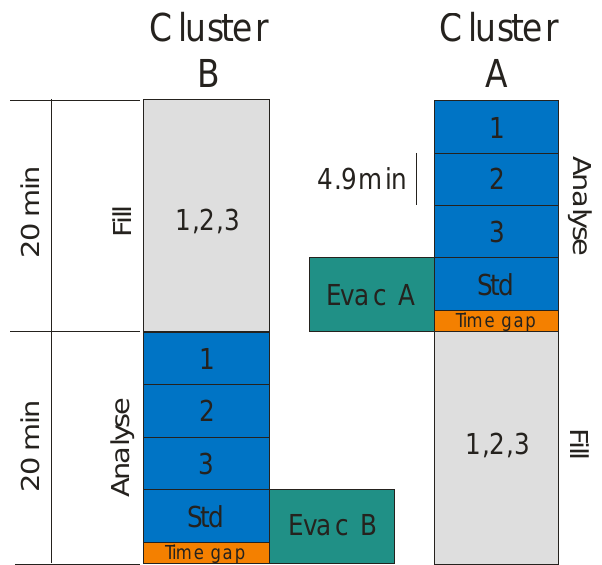
Fig. 2. Sequence control showing alternate filling of one set of bags and simultaneous analysis on the second set of bags. A small time gap after analysis of the standard is required to allow synchronizing to a 20min cycle. This achieves continuous integrated sampling over the chosen sampling